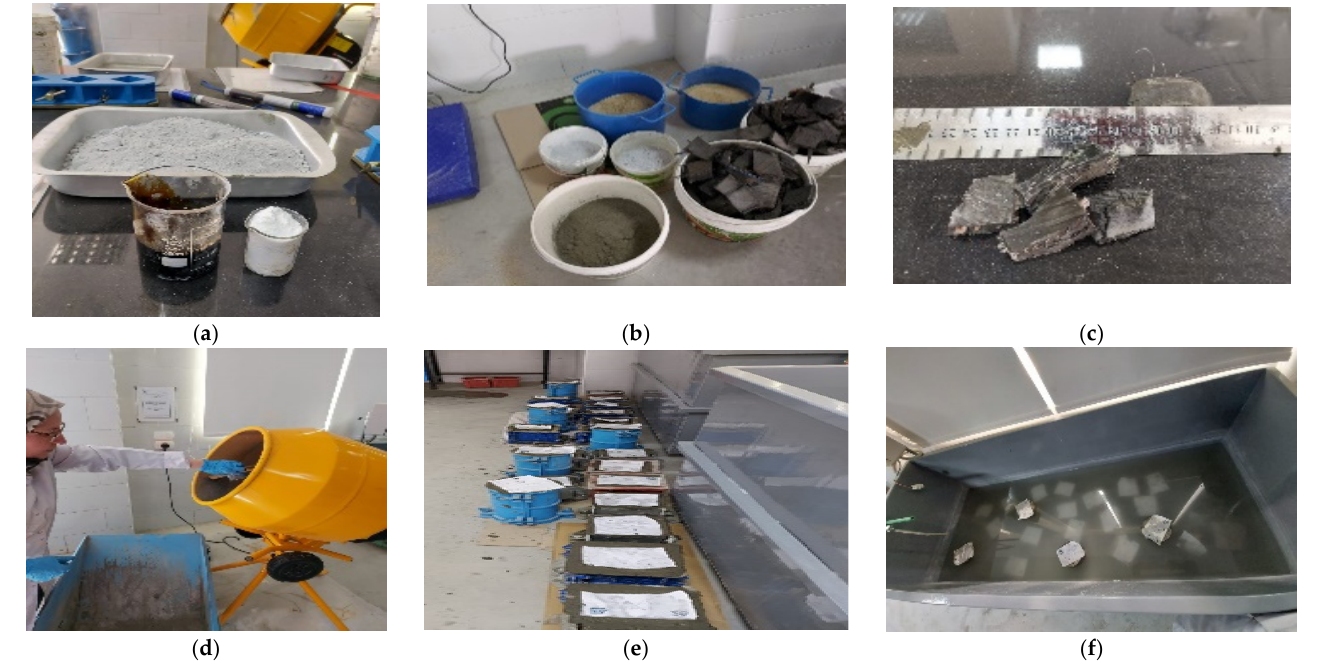
Figure 3. Mixing and preparation of specimens: ( a ) Sikament, FA, and SF; ( b ) cement, sand, and waste tires; ( c ) size of WRT; ( d ) a pan mixer; ( e ) cubic and cylinder specimens; ( f ) water tank curing.